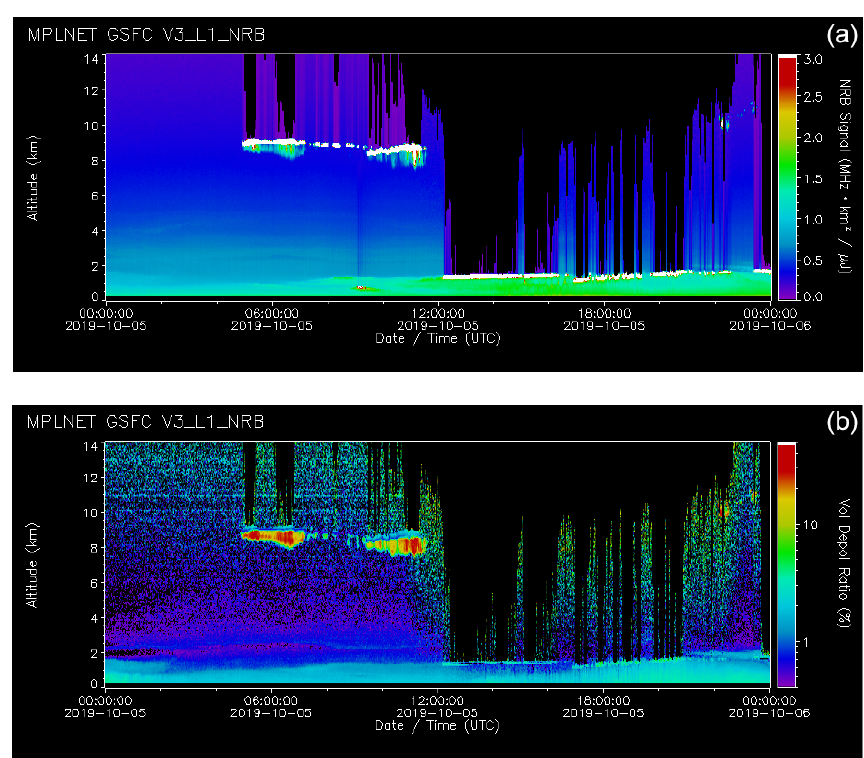
Figure 1. Examples of the NRB (a) and volume depolarization ratio (b) at GSFC on 5 October 2019. Altitude bins where the signal uncertainty is twice the signal strength have been suppressed for easier